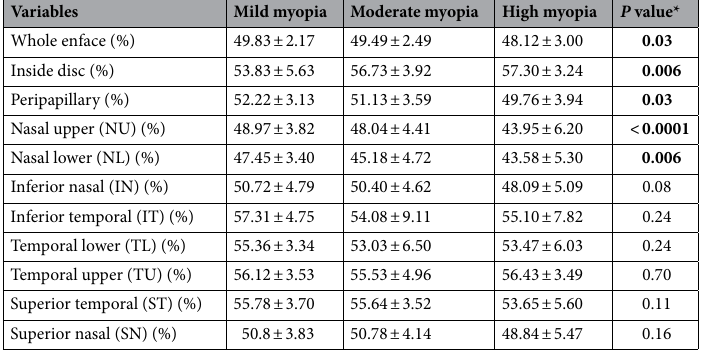
Table 3. The vascular density of the RPC layer. ANOVA: analysis of variance. Significant P values are in bold. *All calculated by one-way ANOVA.